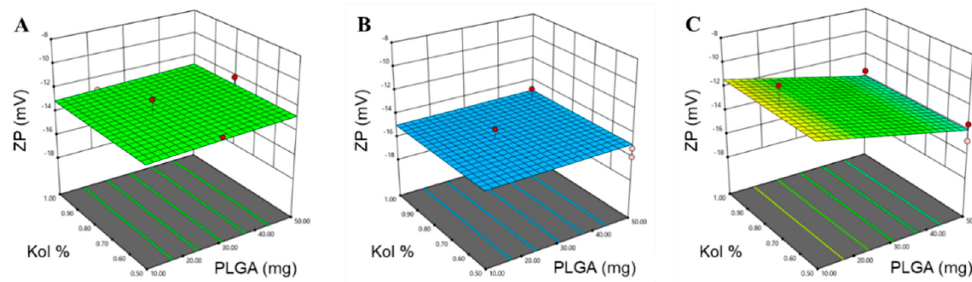
Figure 3. Response surface plots for the effect of the amount of PLGA (mg) and Kol % ( w / v ) on ZP using ( A ) PLGA-7K, ( B ) PLGA-24K and ( C ) PLGA-38K.